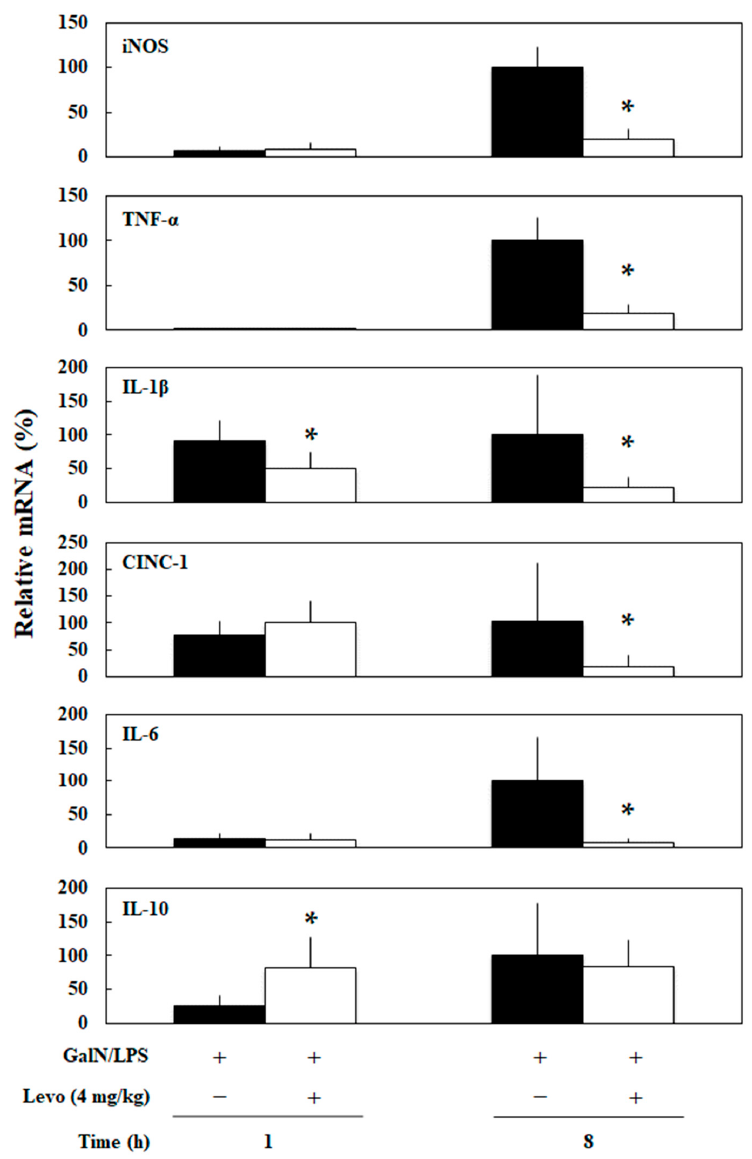
Figure 3. Effect of levosimendan (Levo) on mRNA expression of inflammatory mediators in the livers of D-galactosamine hydrochloride and lipopolysaccharide (GalN/LPS) rats. Each graph consists of bars representing pretreatment with levosimendan or vehicle 1 or 8 h after GalN/LPS injection ( n = 5). “+” indicates that GalN/LPS or Levo was administered; "-" indicates that GalN/LPS or Levo was not administered.* p < 0.05 compared with vehicle control. iNOS, inducible nitric oxide synthase; TNF- α , tumor necrosis factor- α ; IL-1 β , interleukin-1 β ; CINC-1, cytokine-induced neutrophil chemoattractant-1; IL-6, interleukin-6; IL-10, interleukin-10. 3.4. Levosimendan Decreases NO, AST/ALT, and Cytokines in Serum of GalN/LPS Rats The serum levels of NO and liver enzymes (AST and ALT) increased 8 h after GalN/LPS injection, suggesting acute liver injury (Figure 4). In addition, IL-6 and IL-1 β were elevated in the serum after GalN/LPS injection. The pretreatment group of levosi- mendan (4 mg/kg) significantly decreased the levels of NO, AST, and ALT at 8 h ( p < 0.01,